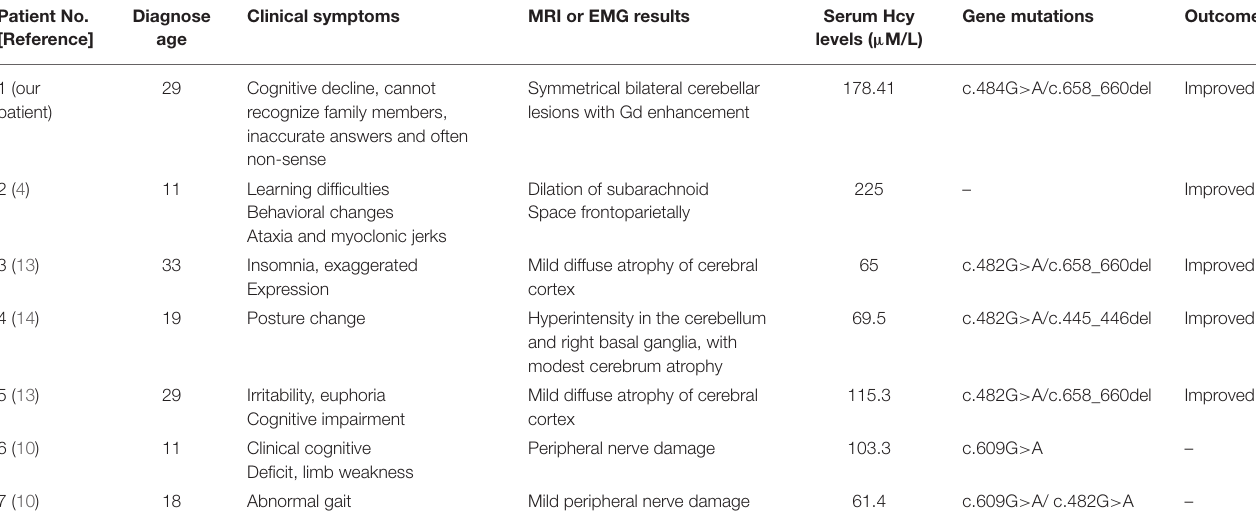
TABLE 1 | The clinical presentations, treatments, and outcomes of cases with late-onset CblC deficiency. Patient No.